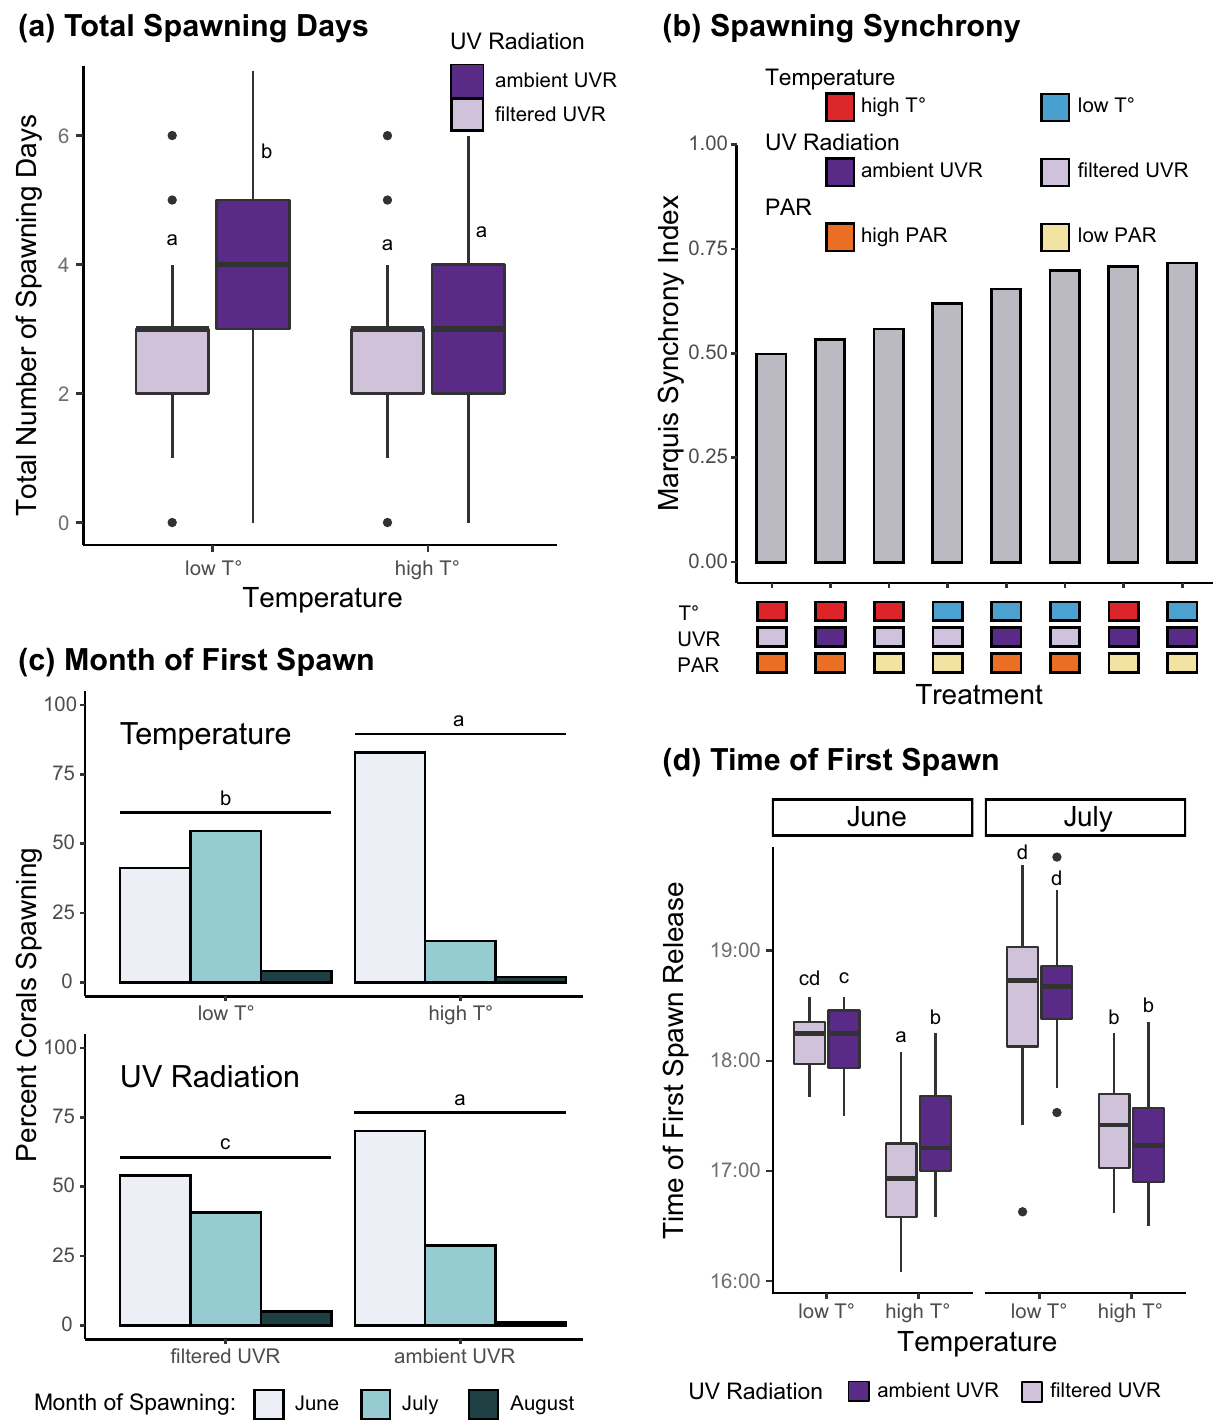
Figure 3. Effects of seawater temperature, PAR, and UV radiation on the timing of coral spawning. ( a ) Both temperature and UVR affected the total number of spawning days that L. scutaria spawned in summer 2018. Low temperature and ambient UVR yielded the highest number of spawning days. ( b ) Spawning synchrony was determined with the Marquis Index for each of the eight treatments, and is ranked from low to high synchrony. The lowest synchrony was found at high temperature, blocked UVR and high PAR, and the highest synchrony was found at low temperature, ambient UVR, and low PAR. ( c ) Both temperature and UVR affected the first month of spawning of L. scutaria . High temperature and ambient UVR both independently yielded a shift in the initial month of spawning, increasing the percentage of corals starting their spawning period in June rather than July. ( d ) Both temperature and the spawning month had direct effects on the time of day that L.scutaria spawned. High temperatures caused corals to spawn earlier than those at low temperatures and spawning occurred later in July in comparison to June. UVR significantly interacted with the month of spawning but did not have a direct effect on the time of spawning. Treatments that share the same letter are not significantly different from each